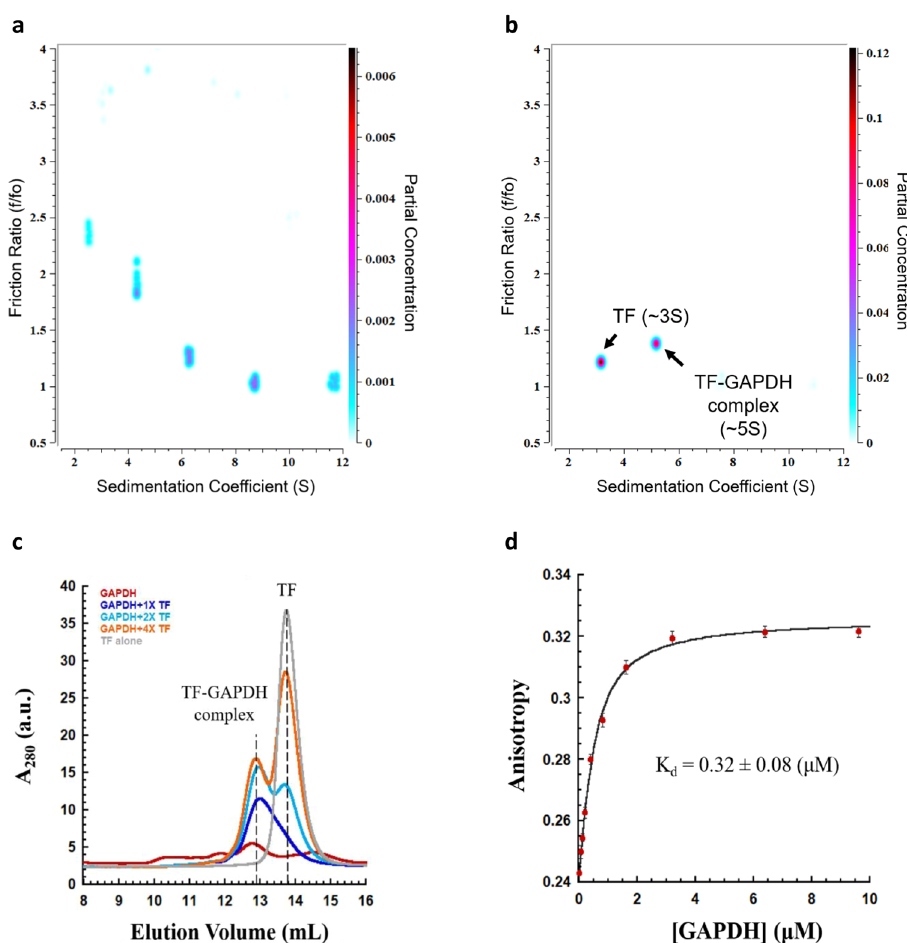
Fig. 1 Interaction of trigger factor and refolding GAPDH. a and b Sedimentation velocity-analytical ultracentrifugation analysis of a 5 μ M refolding GAPDH and b 5 μ M refolding GAPDH in the presence of 3-fold molar excess (15 μ M) of trigger factor at 4 °C shows that the multiple species present for refolding GAPDH are resolved to a single TF – GAPDH complex in the presence of excess trigger factor. All samples were cooled down to 4 °C in the centrifuge over a period of 3 h, until the temperature equilibrated at 4 °C. All experiments were performed in buffer A containing 0.26 M GdnHCl, 4 °C, conditions under which the trigger factor is predominantly monomeric (Supplementary Fig. 3a). Data were analysed by two-dimensional sedimentation analysis, followed by a genetic algorithm-Monte Carlo analysis. c SEC pro fi les were obtained from 5 μ M refolding GAPDH in the absence and in the presence of increasing concentrations of trigger factor (5 – 20 μ M) at 4 °C. All samples were freshly prepared and immediately loaded onto a gel fi ltration column, which was pre-equilibrated with buffer A containing 0.26 M GdnHCl. a.u.: arbitrary units. d Fluorescence anisotropy binding curves of fl uorescently labelling trigger factor upon titration with denatured GAPDH. The titration experiment was performed in buffer A at 4 °C. The data points were fi tted to a quadratic equation to determine the dissociation constant ( K d ). Each anisotropy measurement is the average of 20 independent measurements, and the error reported in the plot is the standard deviation. Value of K d reported is the mean ± s.e.m. of the fi